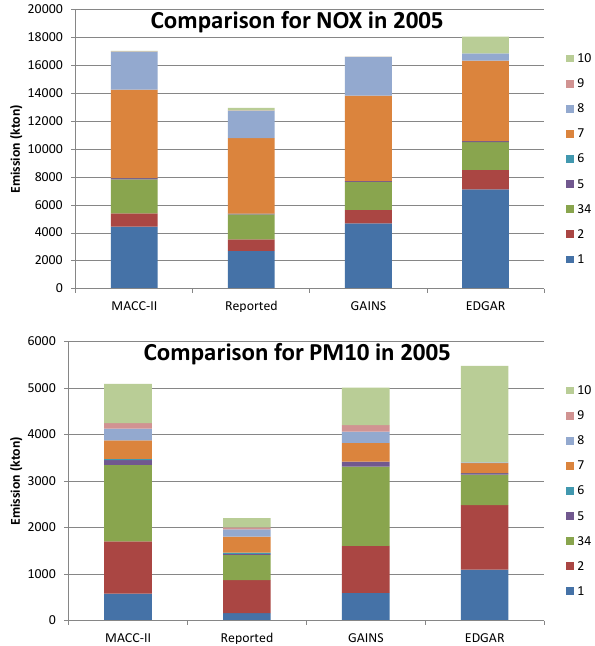
Figure 4. Comparison between the TNO_MACC-II results and the reported emissions, GAINS and EDGAR v4.2, for NO x (upper graph) and PM 10 (lower graph), by SNAP level 1 sector.